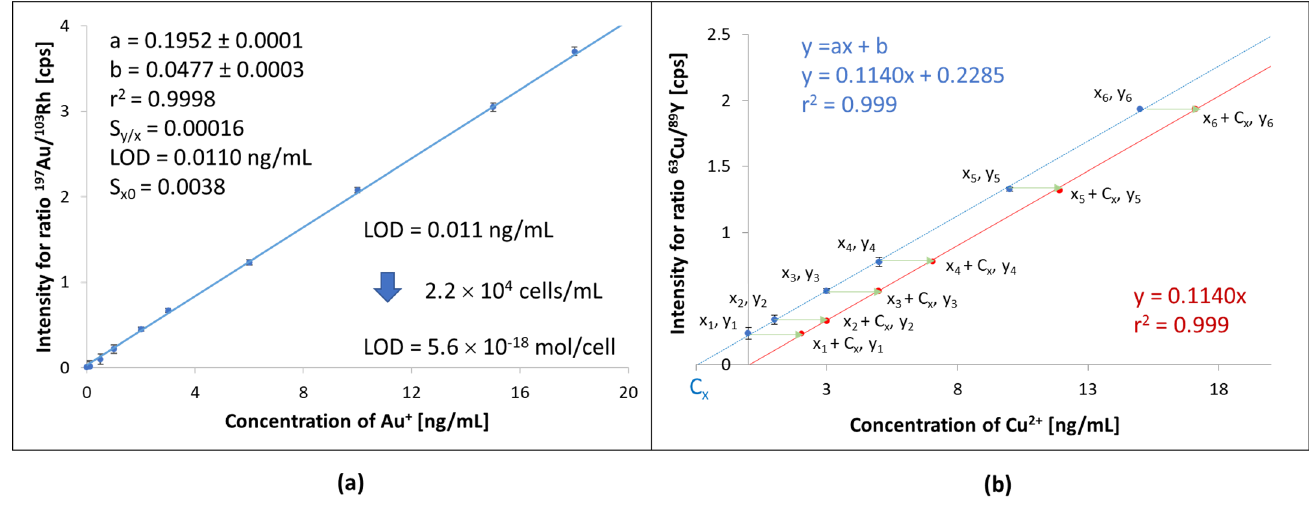
Figure 4. Calibration curve obtained for determination of Au, IISM ( a ) and transformation of calibration curve for determination of copper in cells’ lysate EISM → IISM ( b ). Detailed statistical characteristics of calibration curves for investigated metals is presented in Table S4.